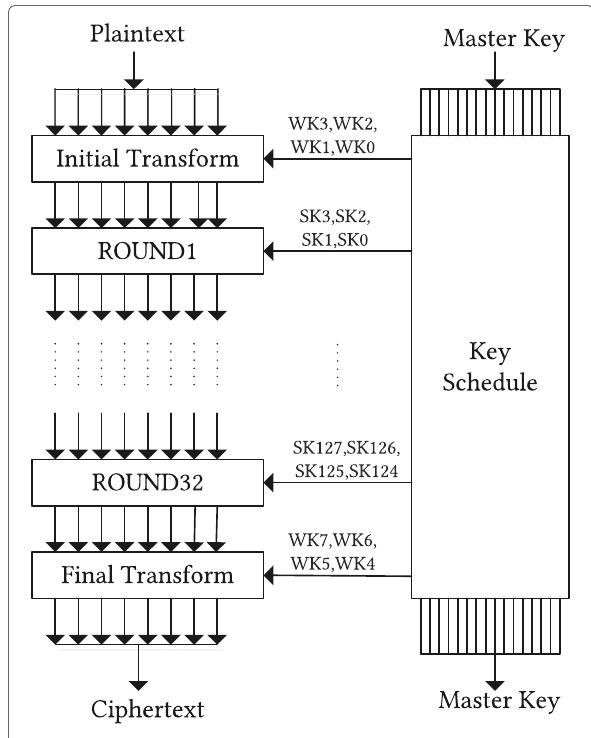
Fig. 6 The encryption process of